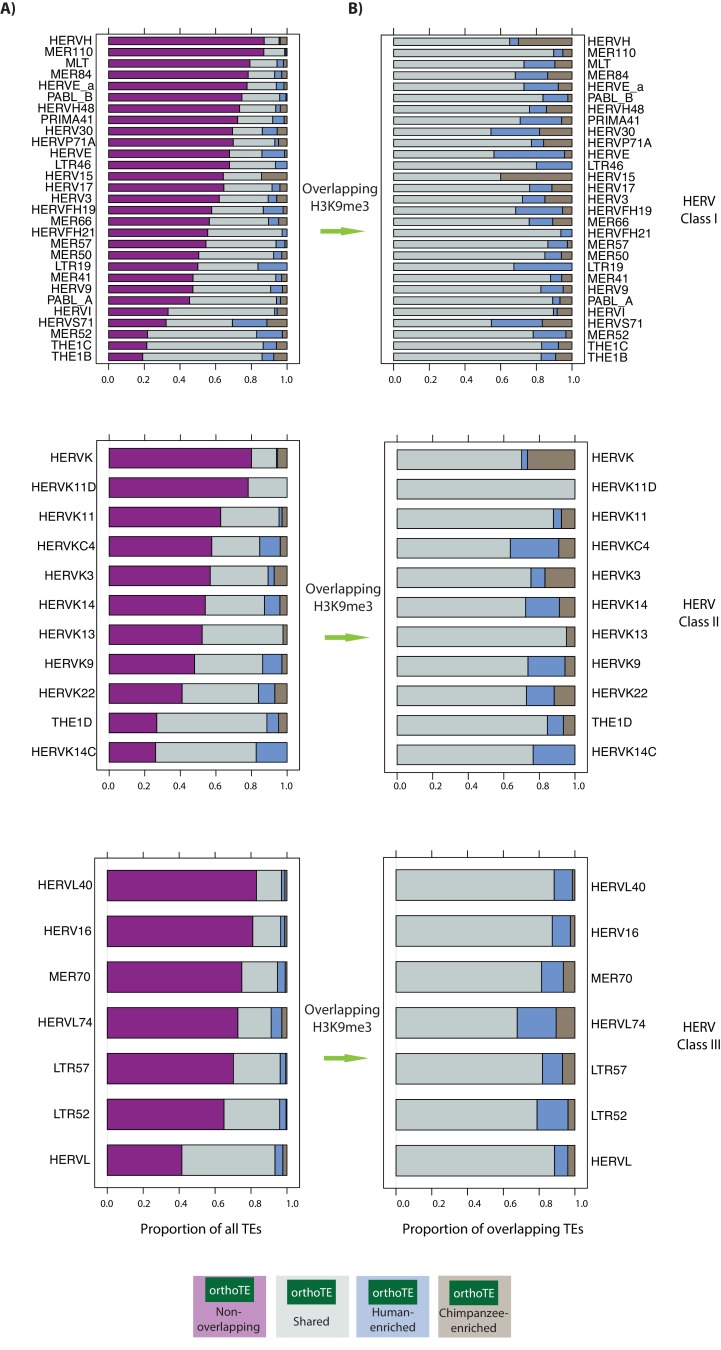
HERV TE types have variable overlap with orthologous H3K9me3 regions and variable inter-species enrichment.(A) The proportion of HERV Class I, II and III types that do not overlap an orthologous H3K9me3 region (magenta), overlap an orthologous region and show similar H3K9me3 enrichment in both species (grey: Shared), are enriched in human (blue: Human-enriched), or are enriched in chimpanzee (brown: Chimpanzee-enriched) are shown. (B) The proportion of HERV types that overlap an orthologous H3K9me3 region and is either Shared, Human-enriched or Chimpanzee-enriched. Curated list of HERV elements from Turelli et al.